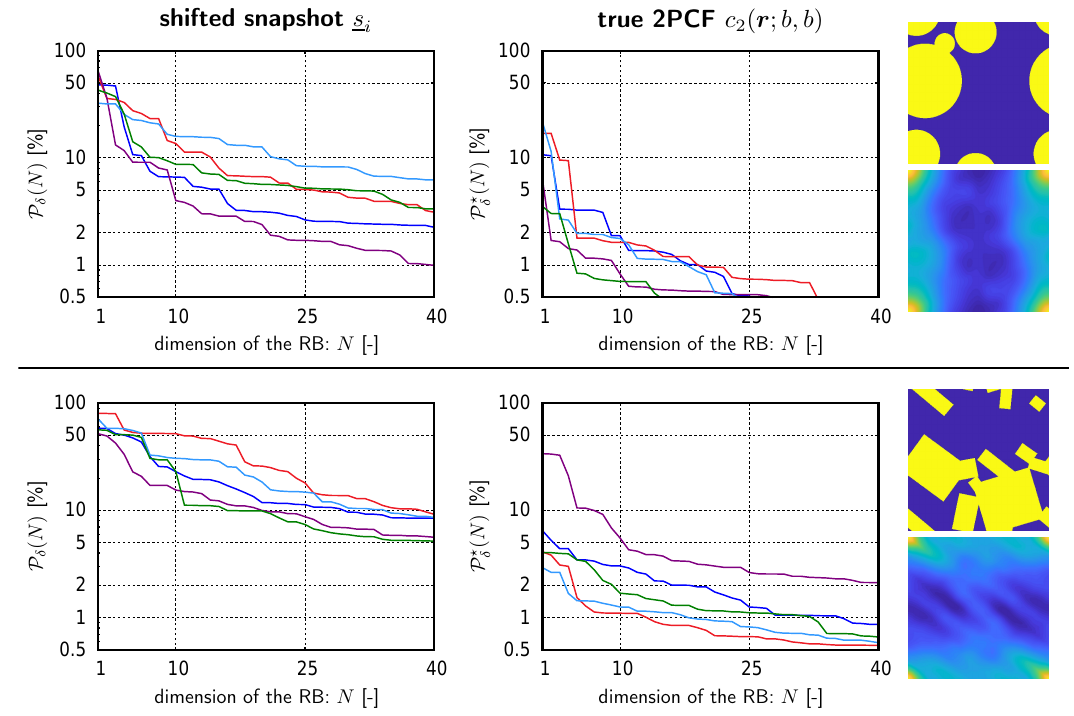
Figure 7. Using the RB of Method C, the relative projection error on the shifted snapshot on the left for five random samples. For comparison the relative projection error of the reconstruction of the actual 2-point correlation function is given on the right for the same five P ∗ δ